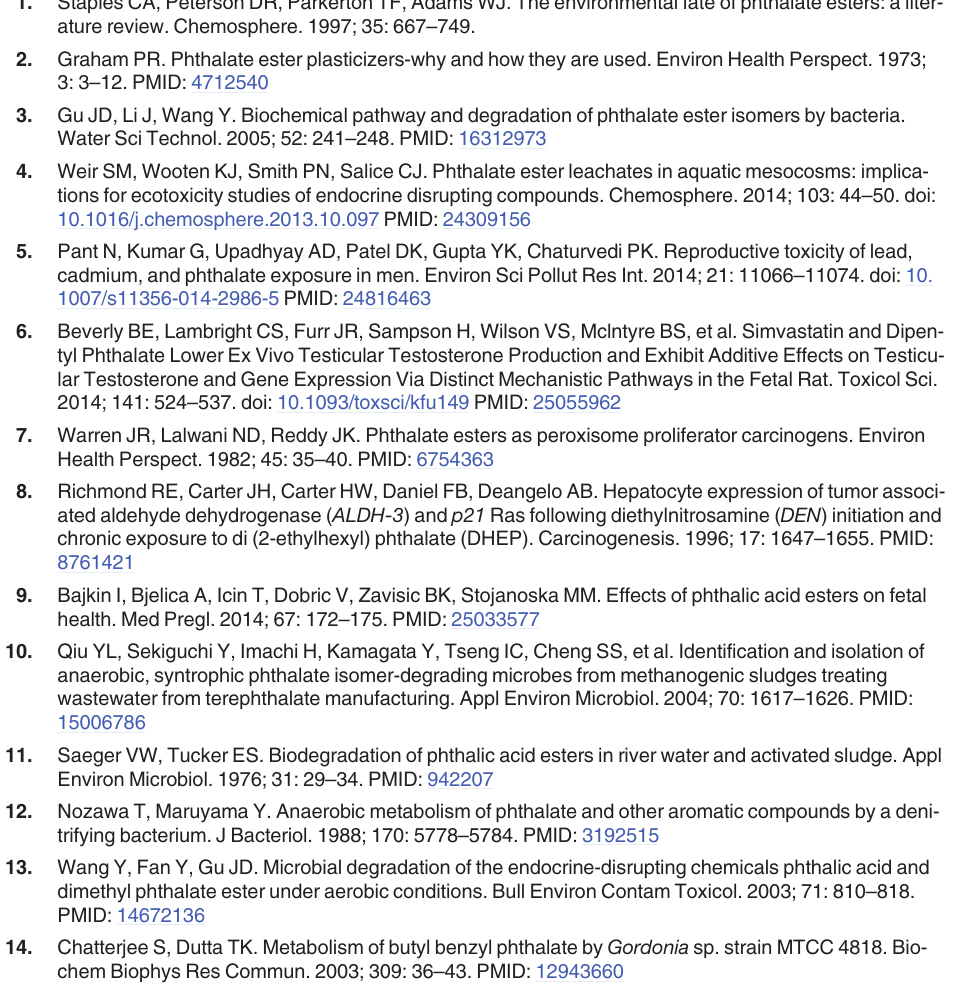
S1 Table. Identities between amino acid sequence of CarEW and those of other reported phthalate esterases or